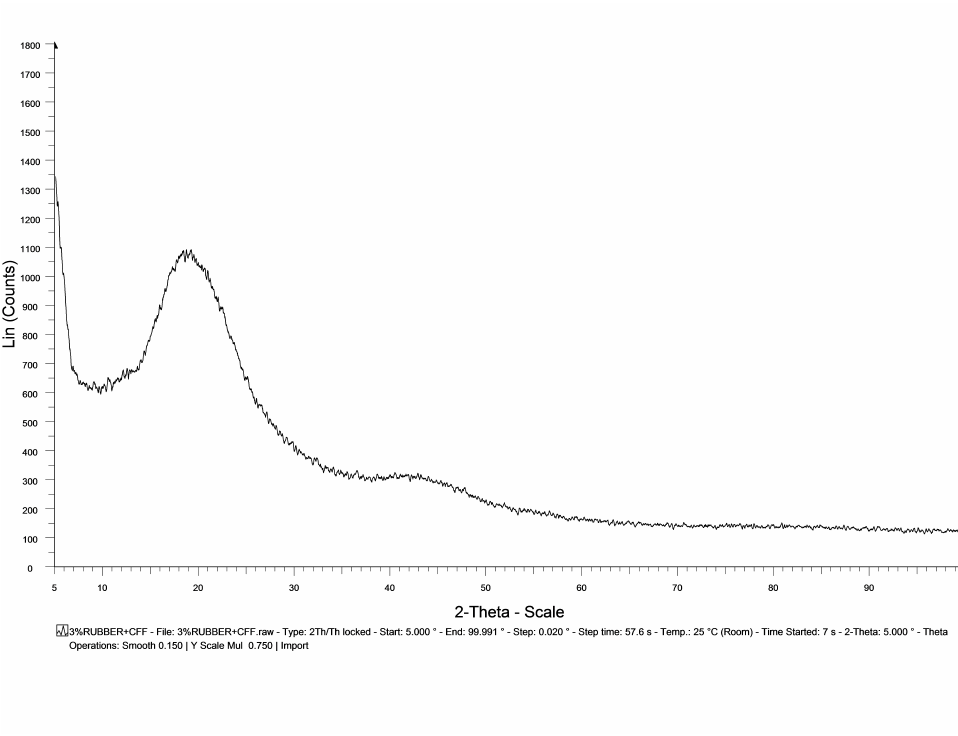
Figure 29: XRD for the sample containing 1.0 wt% CR and 5.0 wt% CFF.